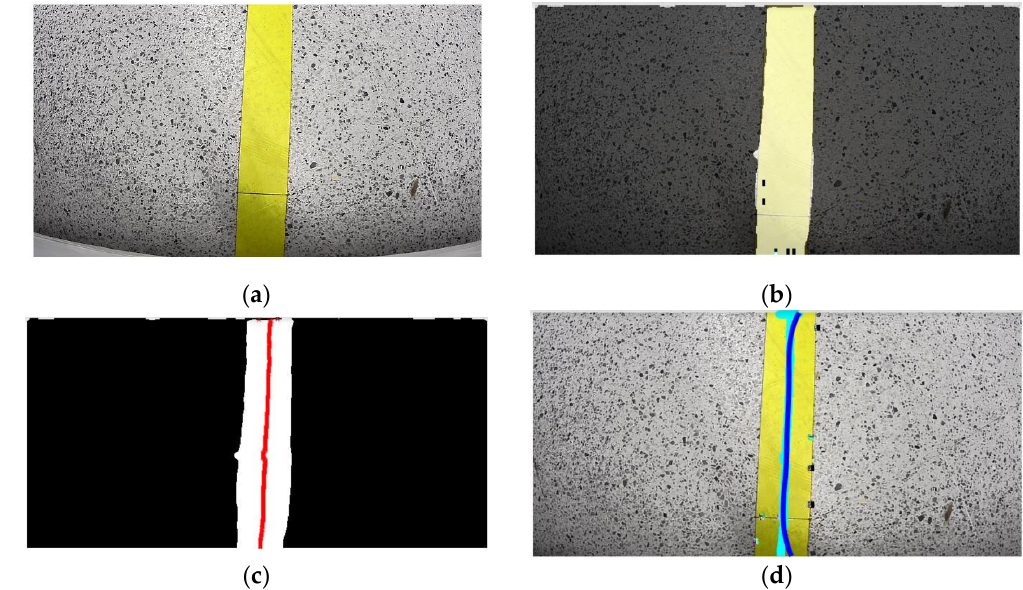
Figure 4. Process of obtaining trajectory: ( a ) Image that AGV takes of the path; ( b ) Semantic segmentation of the path; ( c ) Medium point of the navigable mask; ( d ) Obtained path.